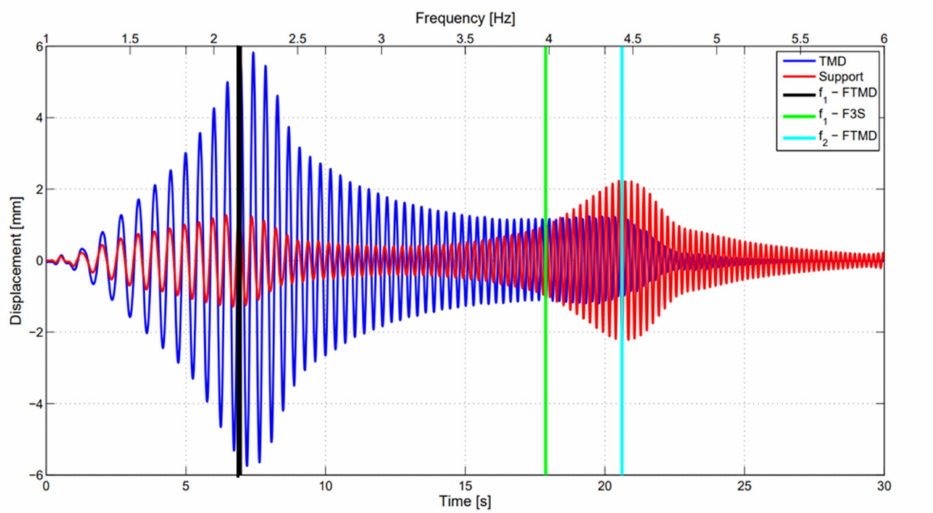
Figure 13. SS. FTMD configuration, detail of the time history of the inter-story drift of the TMD (blue curve) and the relative displacement at support level (red